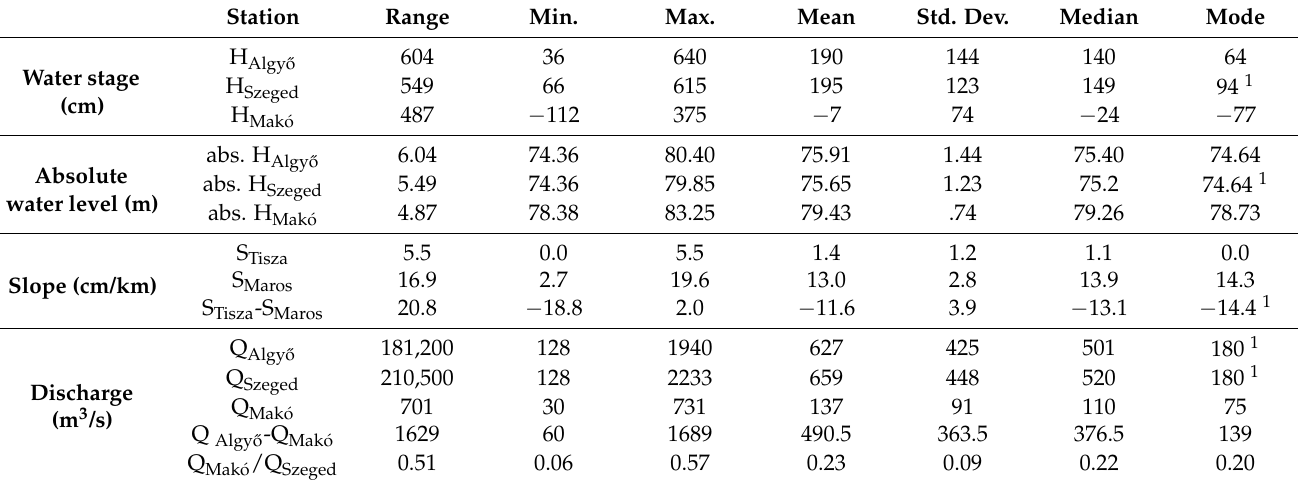
Table 2. Descriptive statistics of the measured and calculated hydrological parameters at the three studied fluviometers.